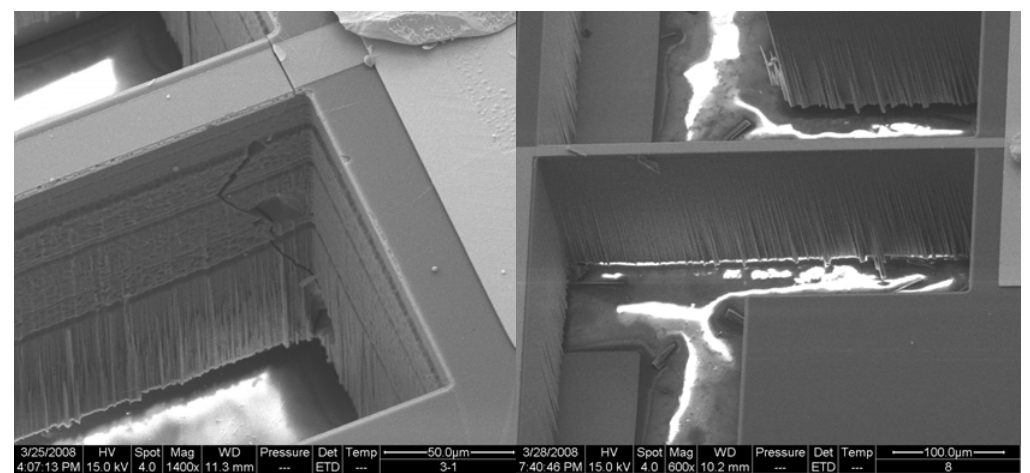
Figure 10. Lateral quality of the beam for a 180 µm thick resonator.